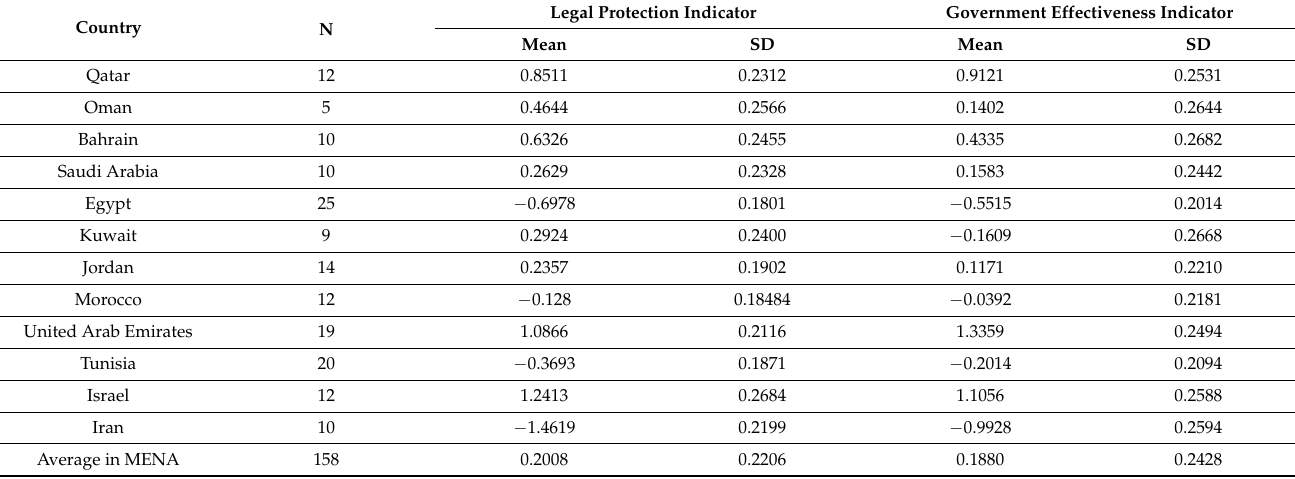
Table 5. External corporate governance